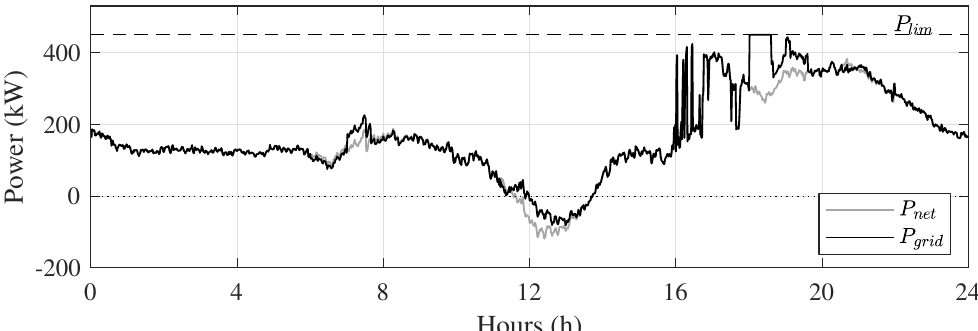
Figure 11. Resulting power between demand and generation and the power exchange with the external grid considering the EVs.